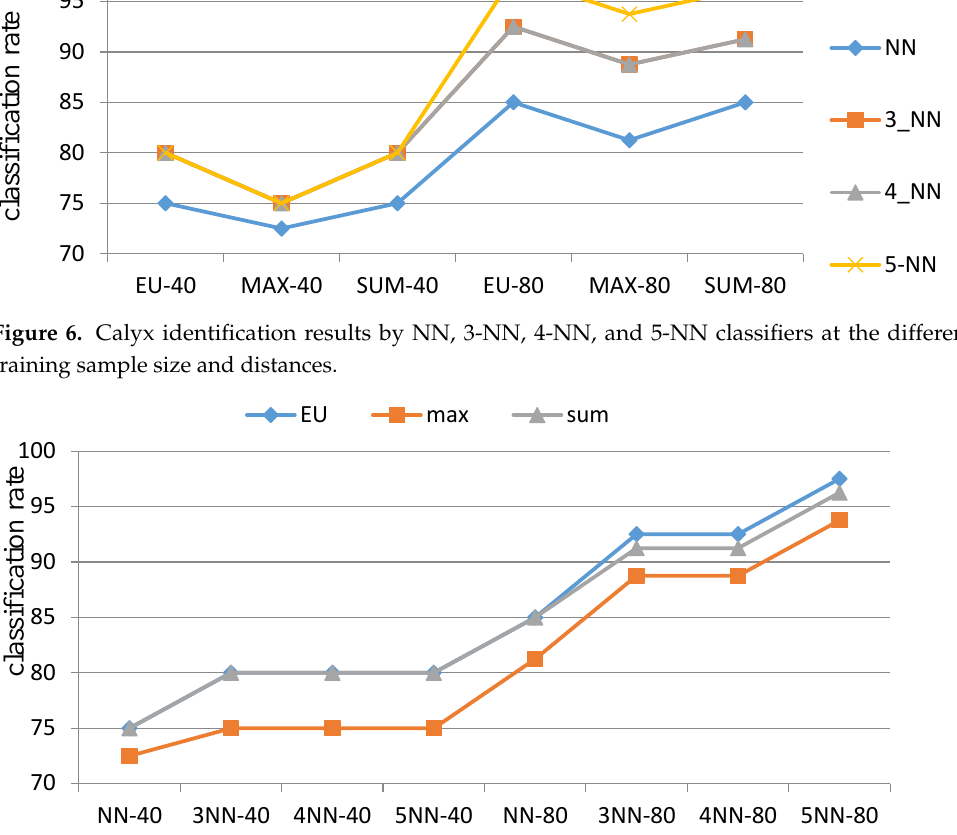
Figure 7. The effect of k parameter and number of training samples on calyx identification at the different metric distances.